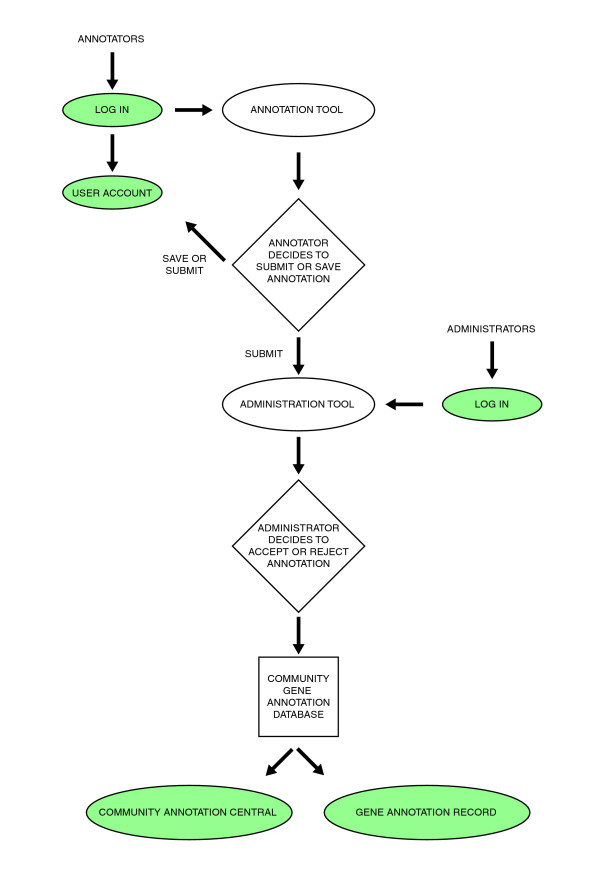
Community annotation review process. Individual Community Utilities are colored green in this diagram.